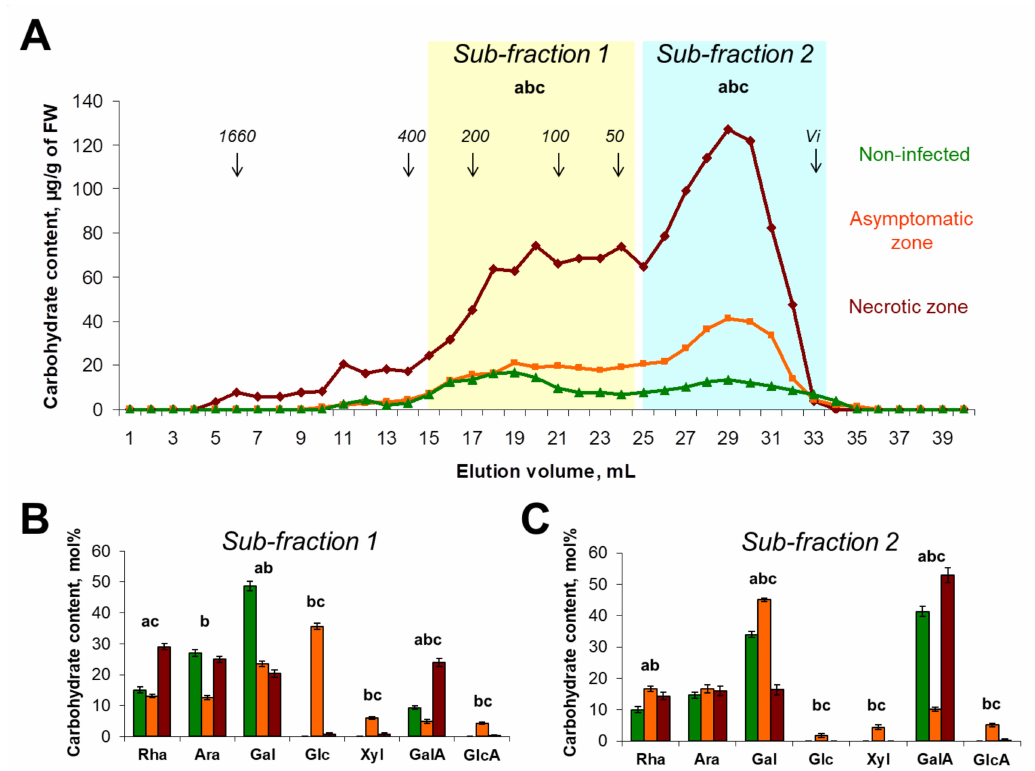
Figure 2. The molecular weight distribution and monosaccharide composition of plant cell wall polysaccharides extracted with 50 mM Na/K-phosphate buffer from the samples of stems of non-infected (green) and Pectobacterium atrosepticum - infected (orange and brown) potato plants: asymptomatic zone (orange) and necrotic zone (brown). ( A ) Elution profiles were obtained using size-exclusion chromatography on a Sepharose CL-4B column; pullulans were used as molecular weight markers; Vi—inclusion volume; values are the means (per g of fresh weight, FW) of three biological replicates. The monosaccharide composition was analyzed in different sub-fractions, i.e., ( B ) sub-fraction 1 and ( C ) sub-fraction 2, which are marked on elution profiles following hydrolyzation with trifluoride acetic acid; values are the means ± SD (mol%) of three biological replicates. Small letters a, b, and c point to the significant difference in the carbohydrate content within a particular sub-fraction (panel A) or in mol% content of a particular monosaccharide (panels B, C) (Mann–Whitney two-sided test, p < 0.05): a—control vs. necrotic zone; b—control vs. asymptomatic zone; c—asymptomatic zone vs.